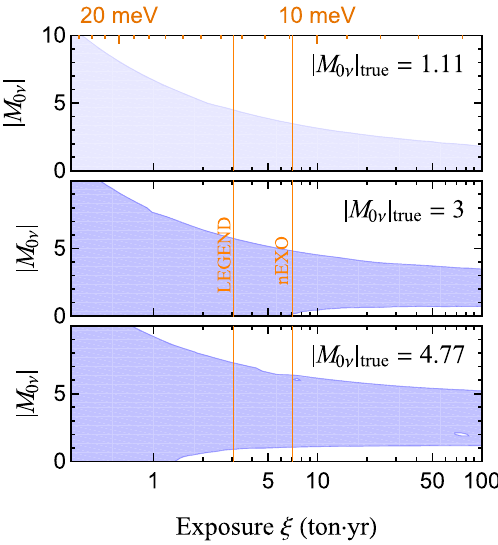
Fig. 7 The 3 σ sensitivities to the NME in terms of the 136 Xe exposure ξ . We assume that a positive signal has been observed in the experi- ment. The signal event number takes the expectation value of the choice (cid:2) (cid:2) (cid:2) M (cid:2) = 0 eV and ρ = 90 ◦ with = 1 . 11 (top panel), 3 m true 3 , true 0 ν true (middle panel) or 4 . 77 (bottom